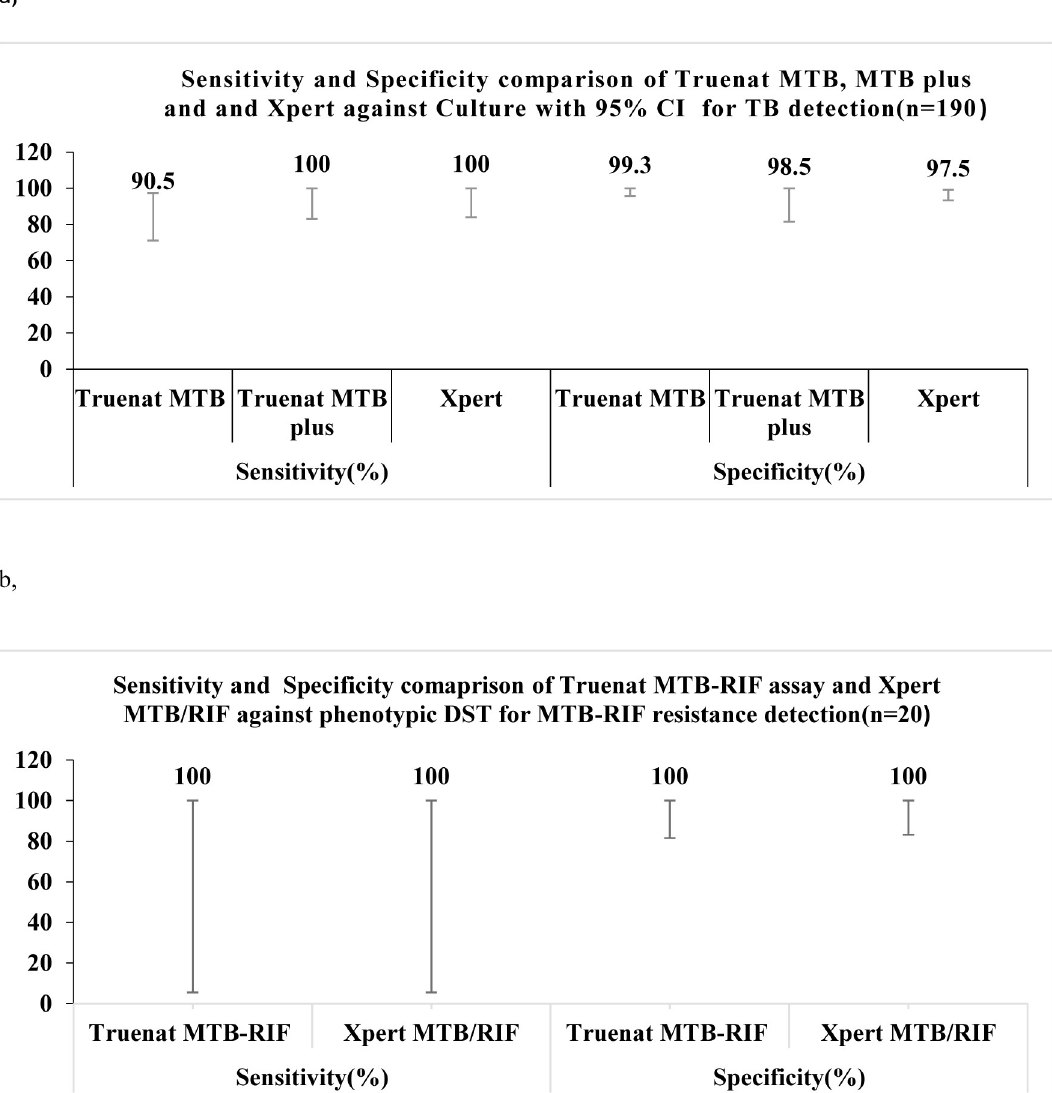
Fig 2. Diagnostic accuracy comparison of Truenat assays and Xpert MTB/RIF against Cultuer/DST for MTB detection (a) and MTB-RIF resistance detection (b).